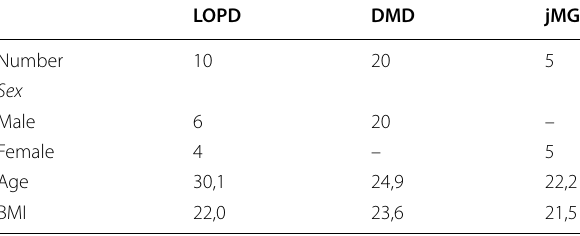
Table 1 Cohort of patients within the analysed transition